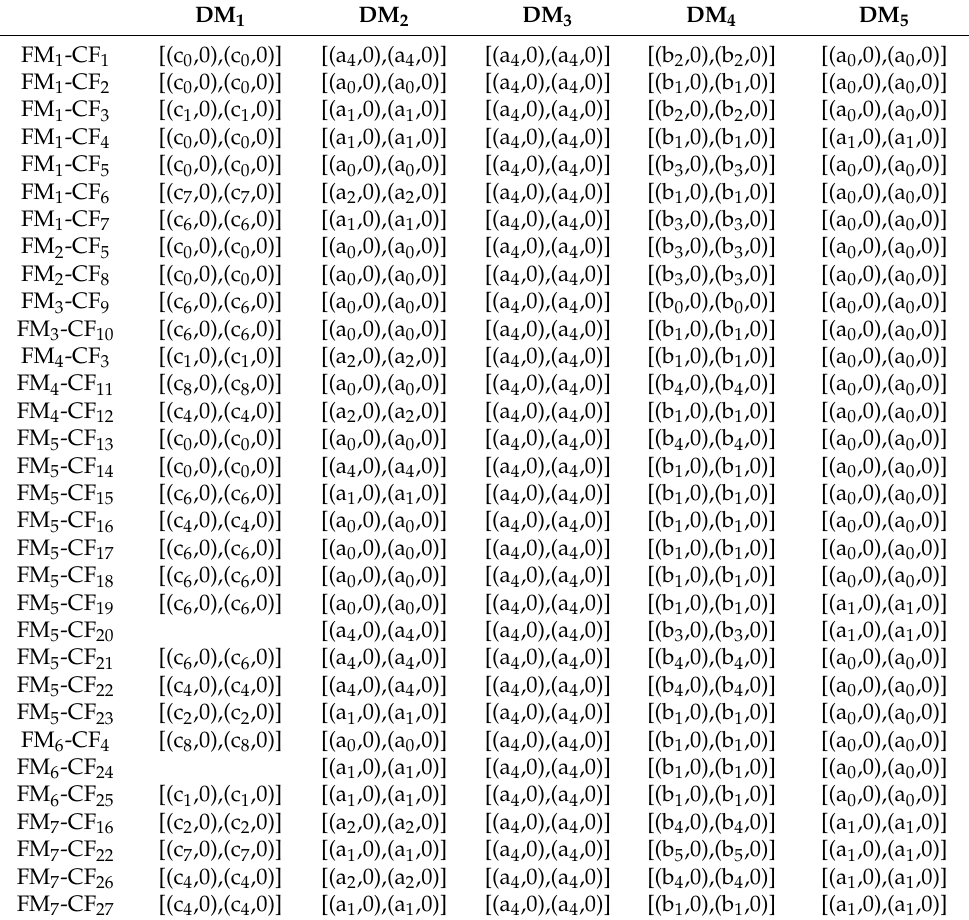
Table 5. Interval 2-tuple linguistic variables for Detection (D).